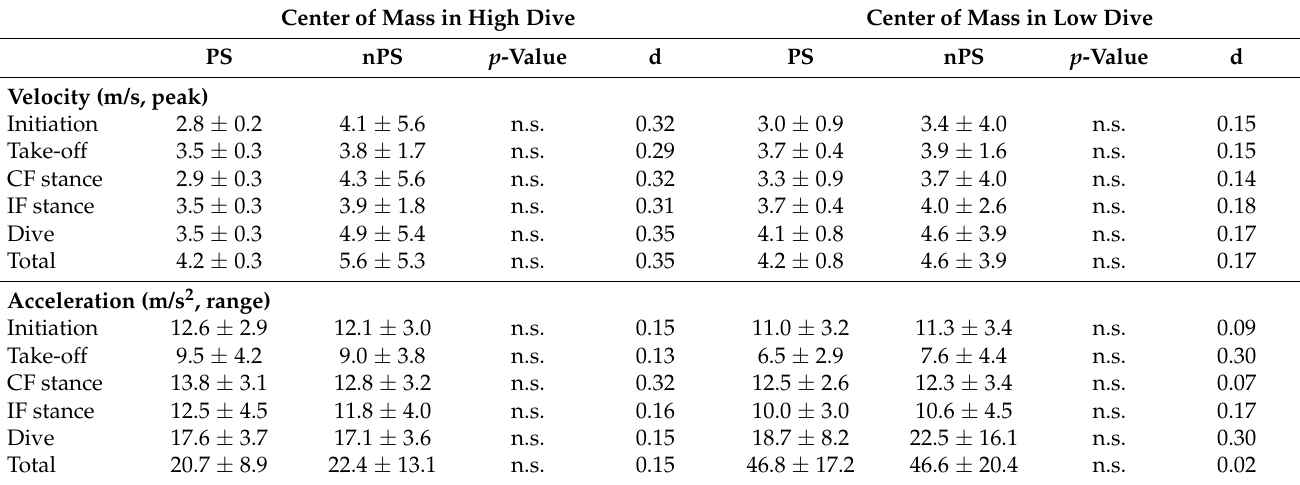
Table 4. Velocity and acceleration of the CoM during high and low dives.